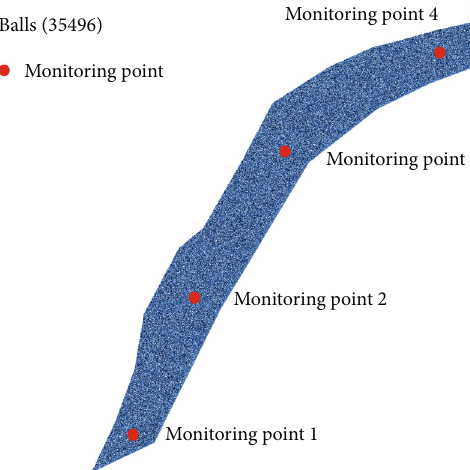
Figure 6: A dynamic simulation model of the typical rocky